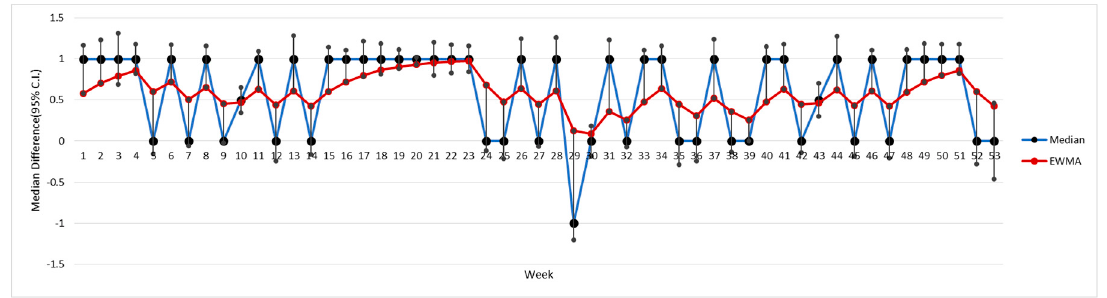
Figure 3. LOS difference of medians and 95% CI between correct and incorrect Dx of pneumonia on admission.